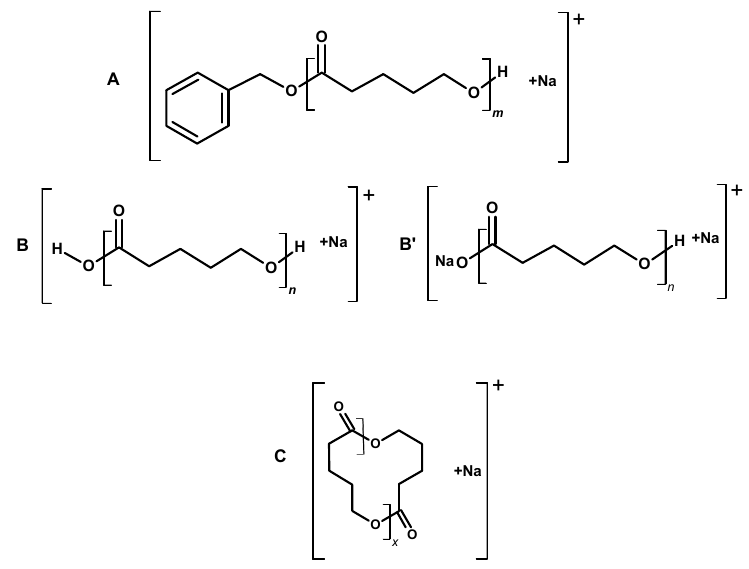
Figure 3. The structures of the ions observed in ESI ‐ MS of PVL.